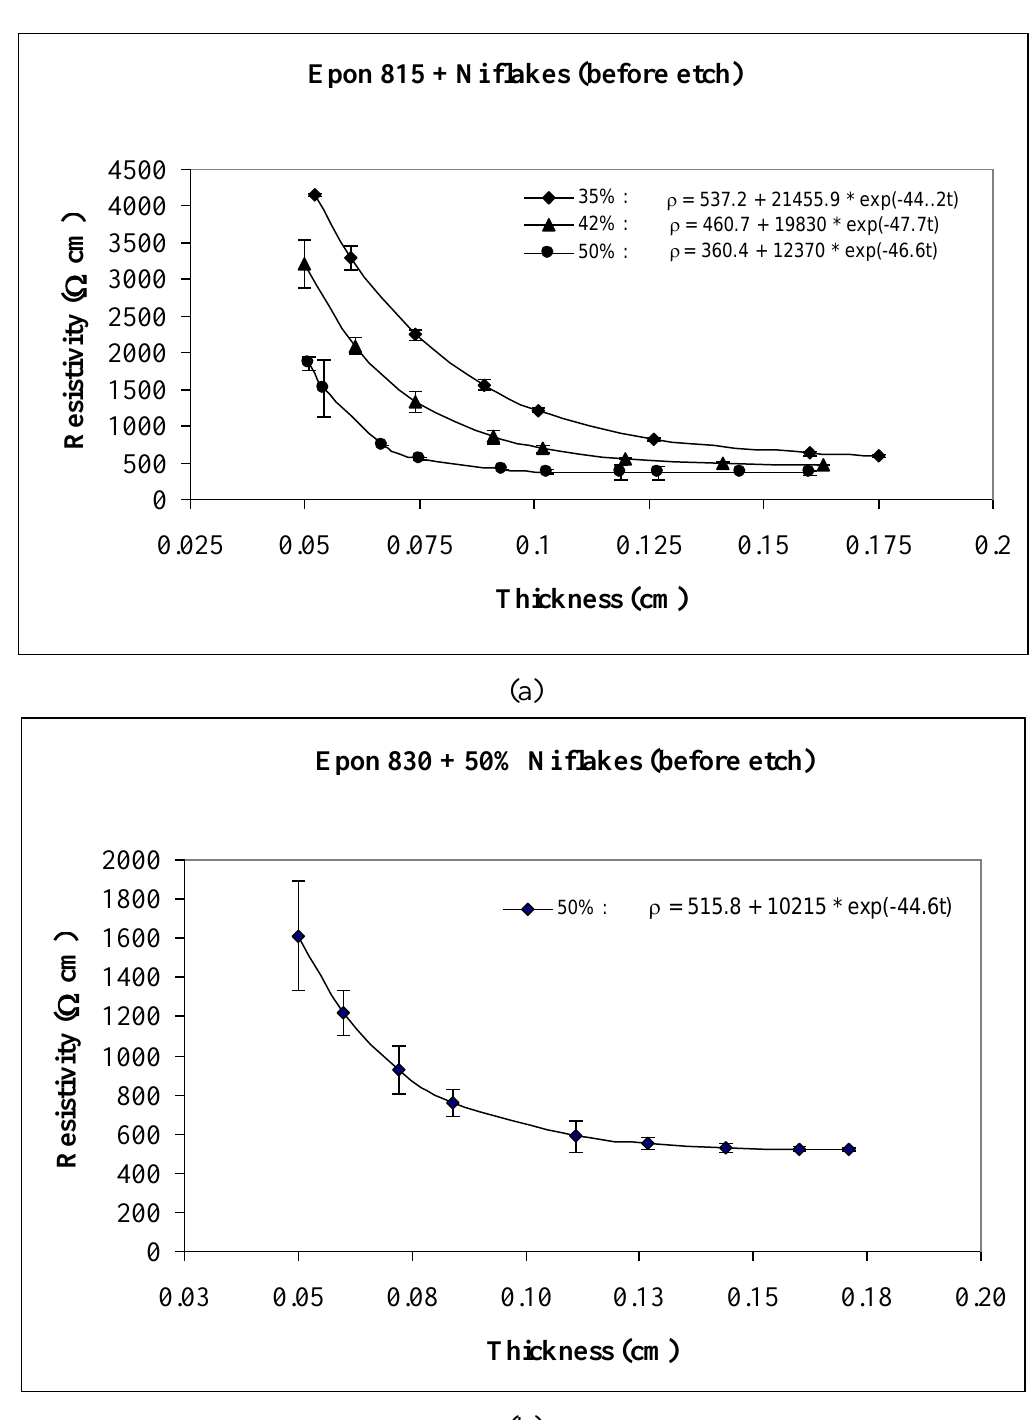
Figure 3. Thickness-dependent resistivity of Epon 815C films filled 35%, 42% and 50% by volume with unetched nickel flakes ( a ), and 830 films filled 50% by volume with unetched nickel flakes ( b